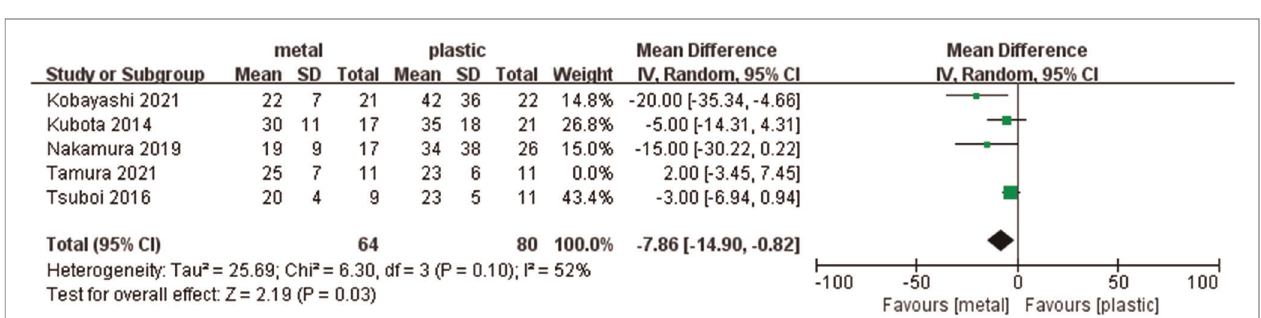
FIGURE 5 | Forest plot of sensitivity analysis of postoperative hospitalization